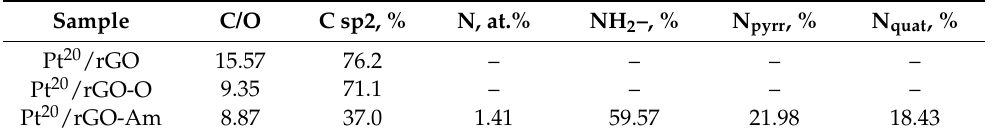
Table 2. Some results of XPS spectrums fitting of Pt 20 /rGO, Pt 20 /rGO-O and Pt 20 /rGO-Am.